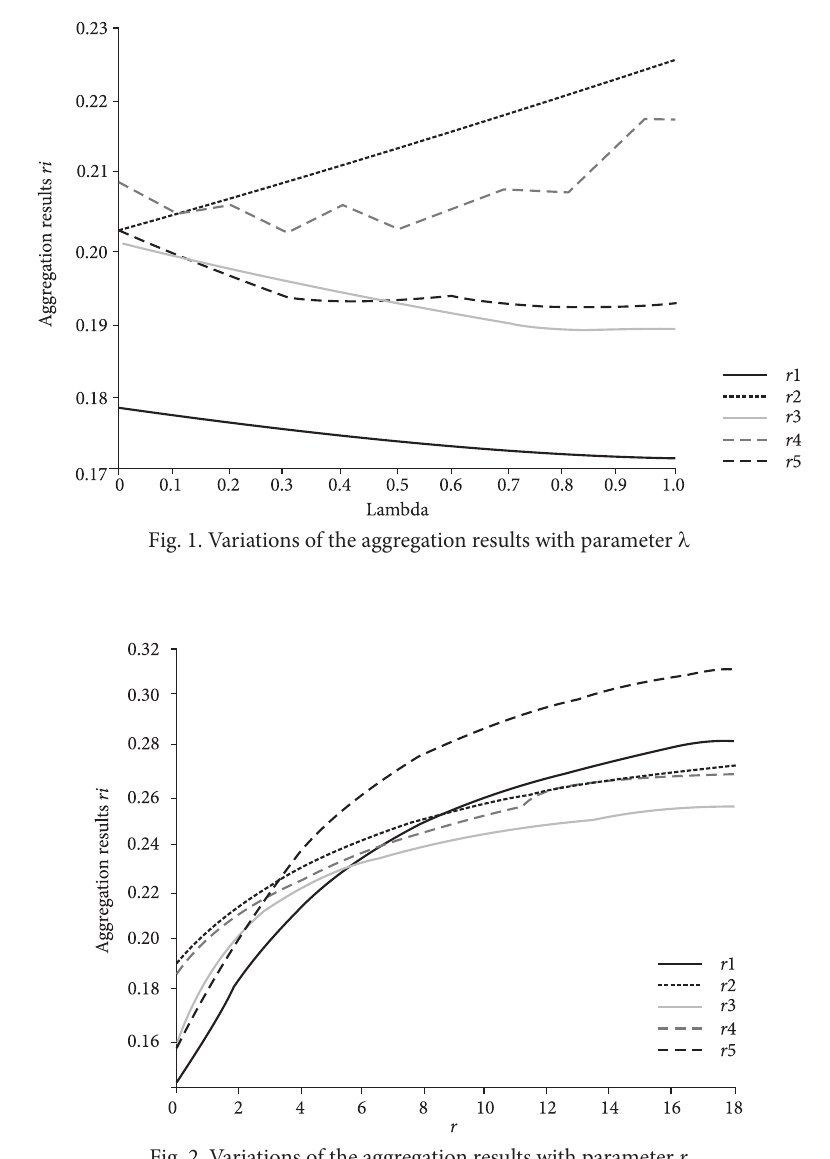
Fig. 2. Variations of the aggregation results with parameter